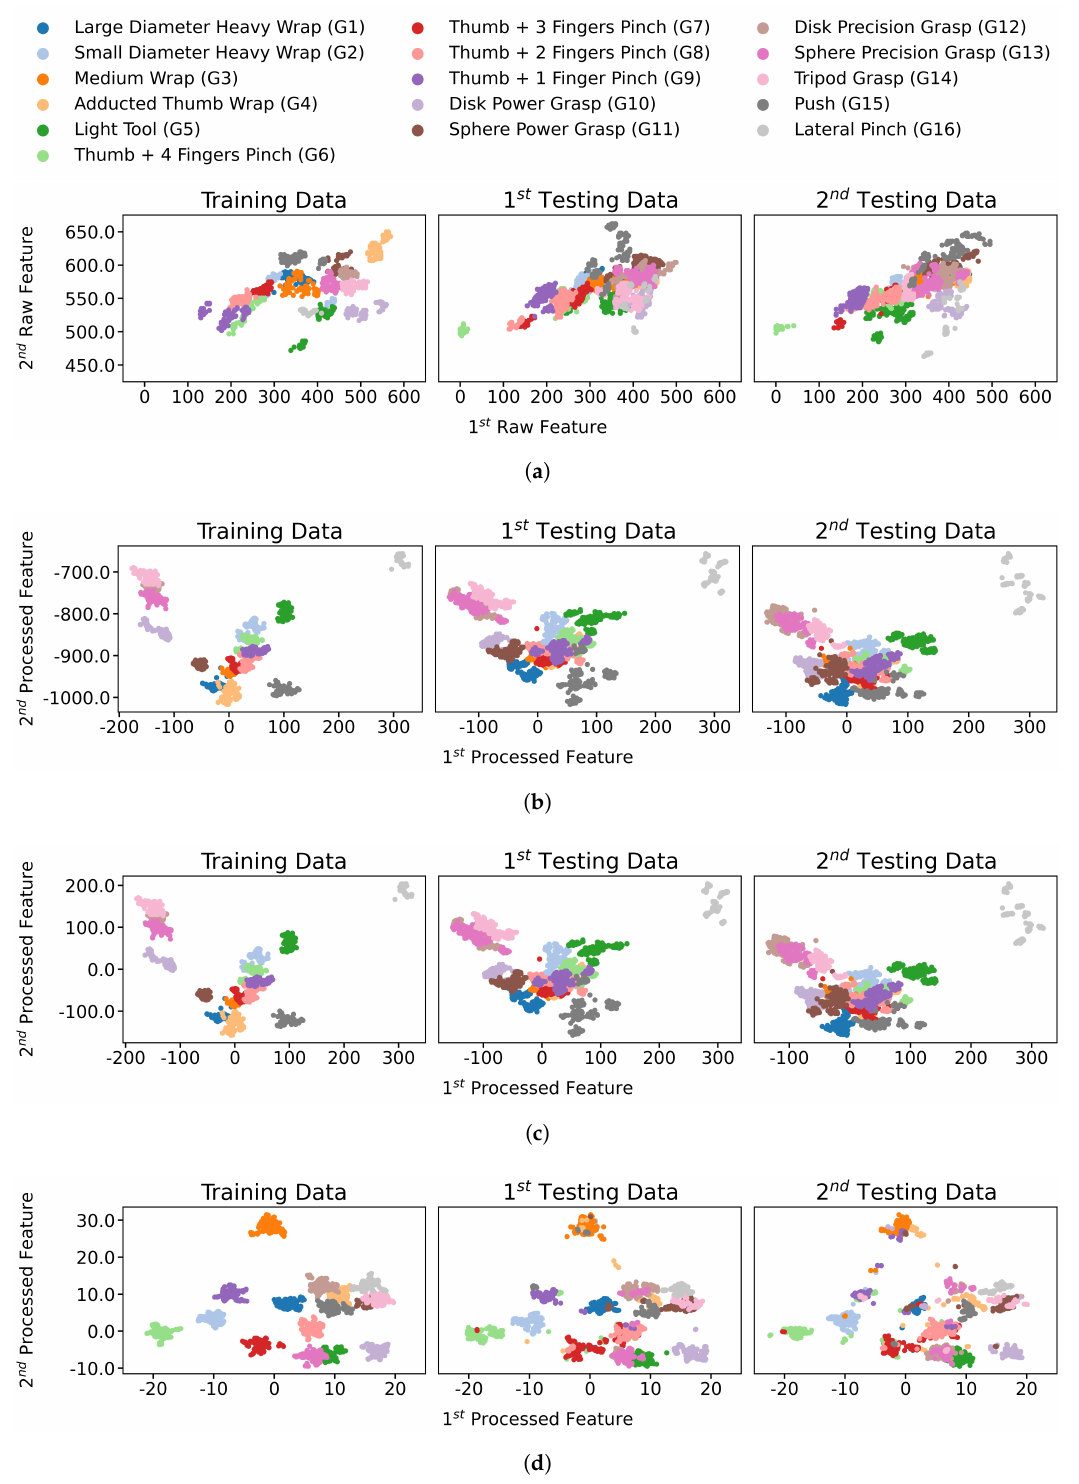
Figure 3. Feature spaces comparison between before- and after- applying each pipeline possessing step for all participant 2 data gestures, using the first two dimensions for each feature space. ( a ) Sessions data using raw features. ( b ) Sessions data post applying FDA, the first step of the pipeline. ( c ) Sessions data post applying PCA, the second step of the pipeline. ( d ) Sessions data post applying UMAP, the final step of the